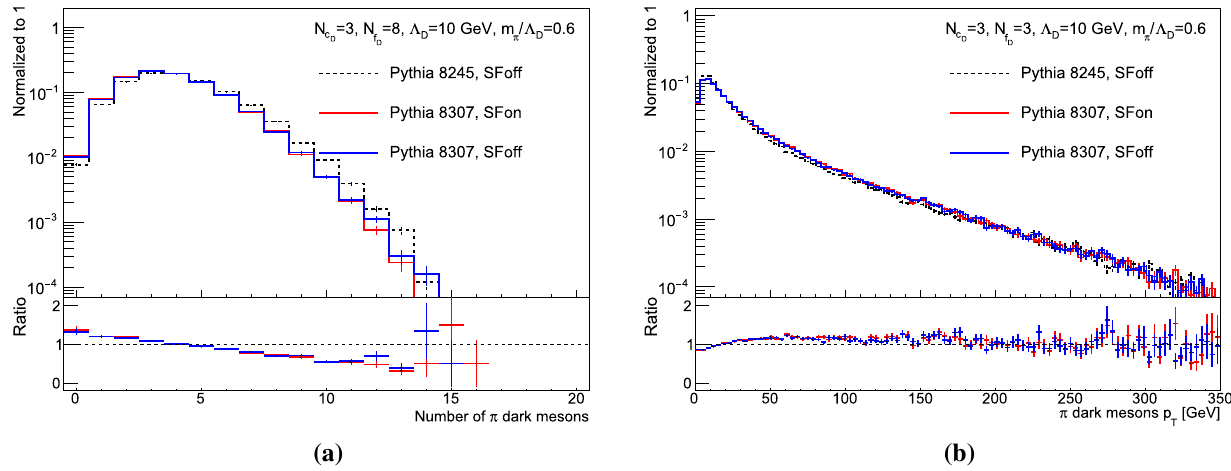
= 3, N = 8 model: a distribution of the number of dark pions, b dark pion p Fig. 33 N c f D D the distributions of the new HV module scenarios to the nominal one